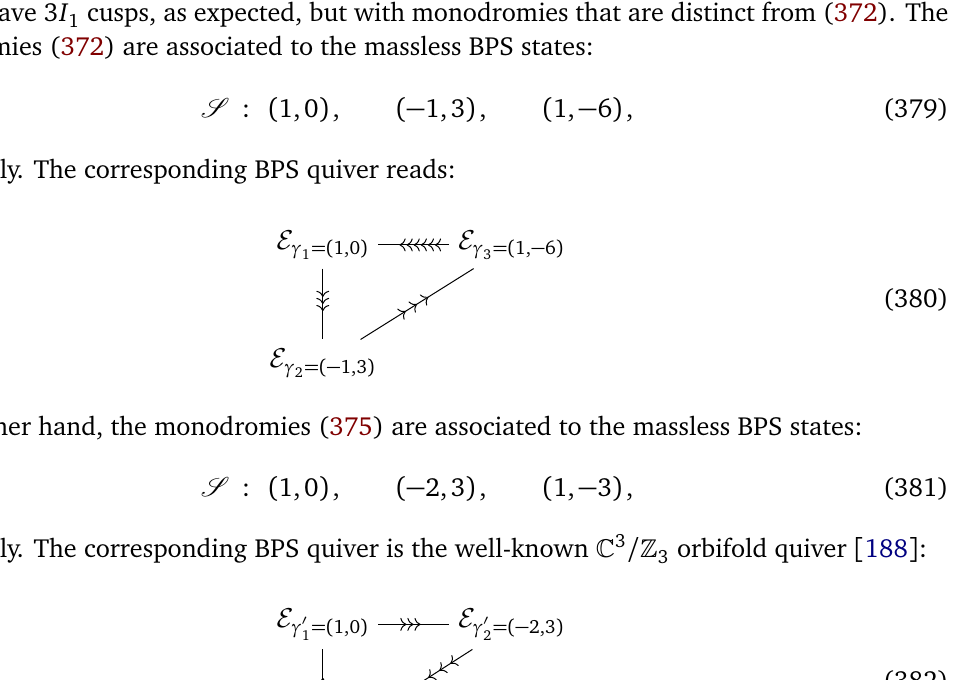
cusps at τ = 0, 3 and 1 2